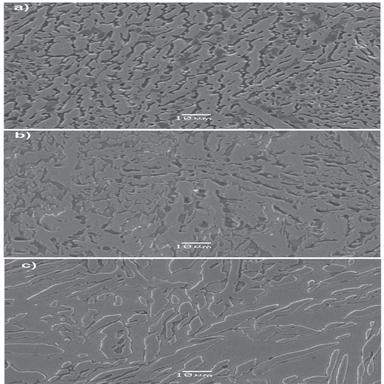
SEM SE images of SDSS-Nb with heat treatments, a) SDSS-Nb with heat treatment at 1030 ◦C; b) SDSS-Nb with heat treatment at 1060 ◦C; c) SDSS-Nb with heat treatment at 1090 ◦C.